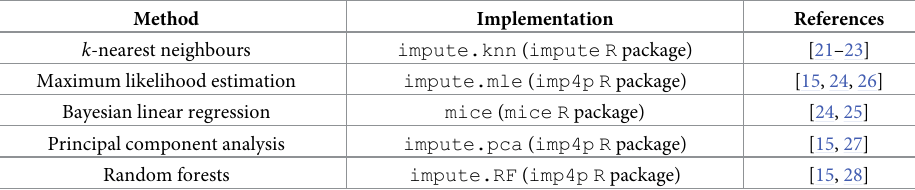
Table 1. Overview of the imputation methods considered in this